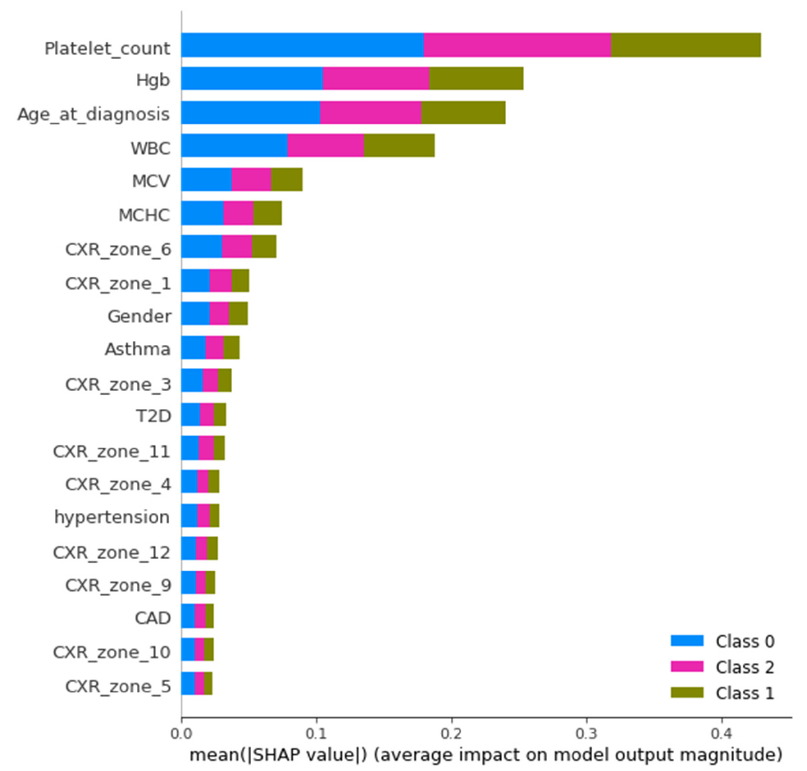
Figure 9. Mean (SHAP value) for the prediction of ventilatory support patients (Case 2).